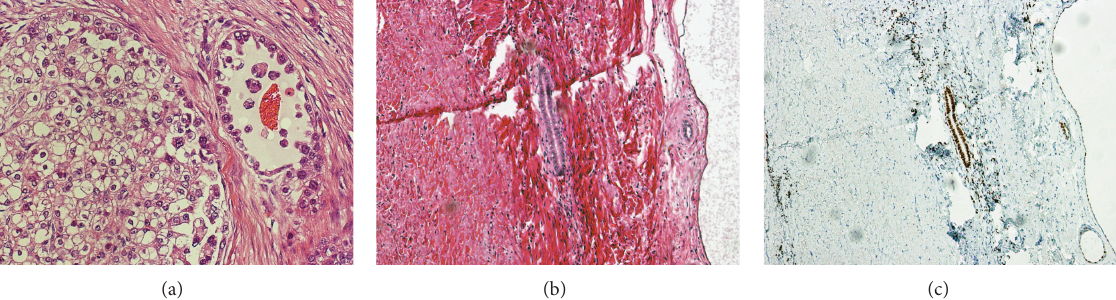
Figure 2: (a) In pathologic examination, many hobnail-shaped cells and clear cell were found. These are characteristic of clear cell adenocarcinoma (hematoxylin and eosin stain, magnification × 100). (b) Pathologic examination showed clear cell adenocarcinoma and endometriosis. It suggests a malignant transformation from endometriosis of the abdominal wall (hematoxylin and eosin stain, magnification × 100). (c) Staining estrogen receptor (ER), magnification ×